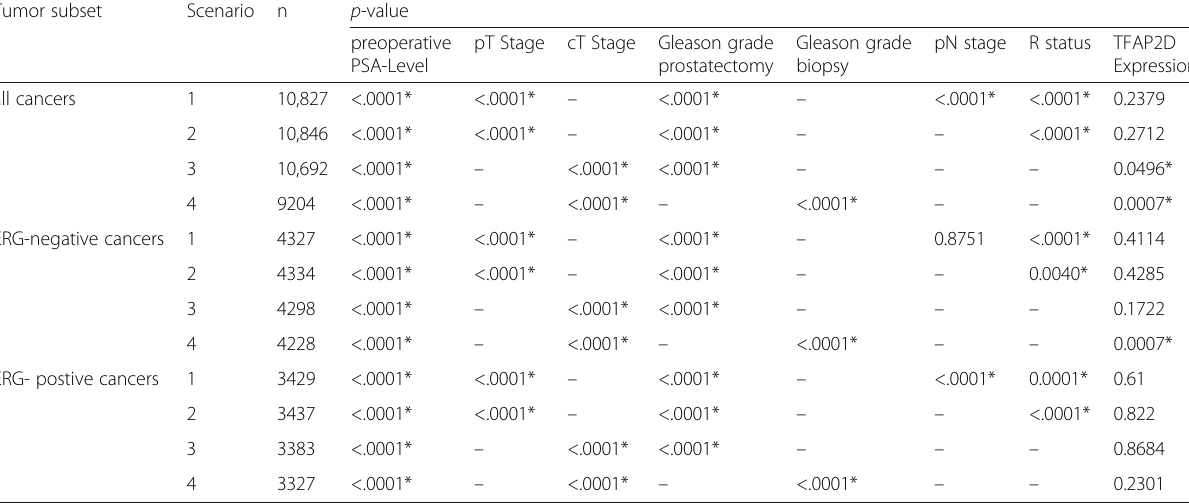
Table 4 Multivariate Cox regression analysis including established prognostic parameters and the TFAP2D expression in all prostate cancers and in the subsets of ERG negative and ERG positive prostate cancers Tumor subset Scenario n p -value